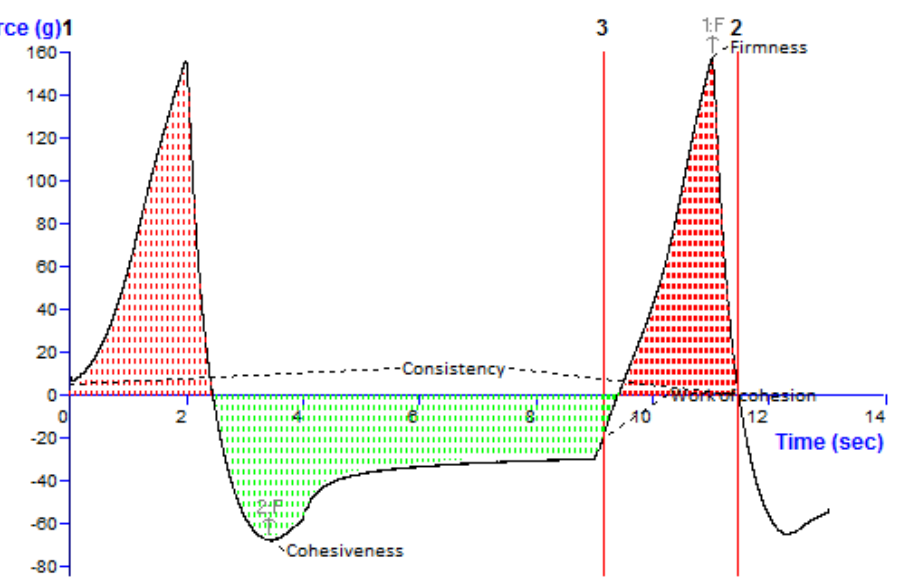
Figure 7. Viscosity vs. shear rate graph of QCT@NG.